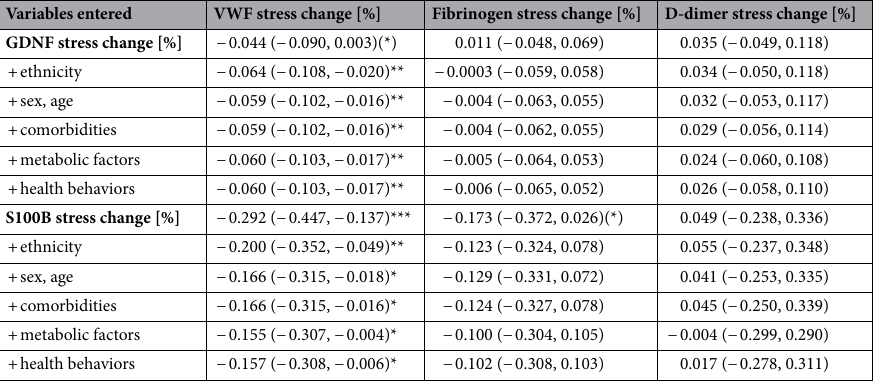
Table 5. Regression models for the associations between stress-induced changes in neurotrophins and hemostatic factors. GDNF, glia cell-line derived neurotrophic factor; S100B, S100 calcium-binding protein B; VWF, von Willebrand factor. Unstandardized beta-coefficients B (95% confidence interval) indicate the percent change in hemostatic factors from baseline with a 1% increase in neurotrophins from baseline, subsequently adjusted for blocks of covariates. Significance level: (*) p < 0.10, * p < 0.05, ** p < 0.01, *** p < 0.001. Comorbidities: Human immunodeficiency virus positive status, history of atherothrombotic disease. Metabolic factors: Body mass index, hemoglobin A1c, total cholesterol to high-density lipoprotein cholesterol ratio; mean 24-h arterial pressure, estimated glomerular filtration rate, high-sensitivity C-reactive protein. Health behaviors: Current smoking, physical activity, excessive alcohol